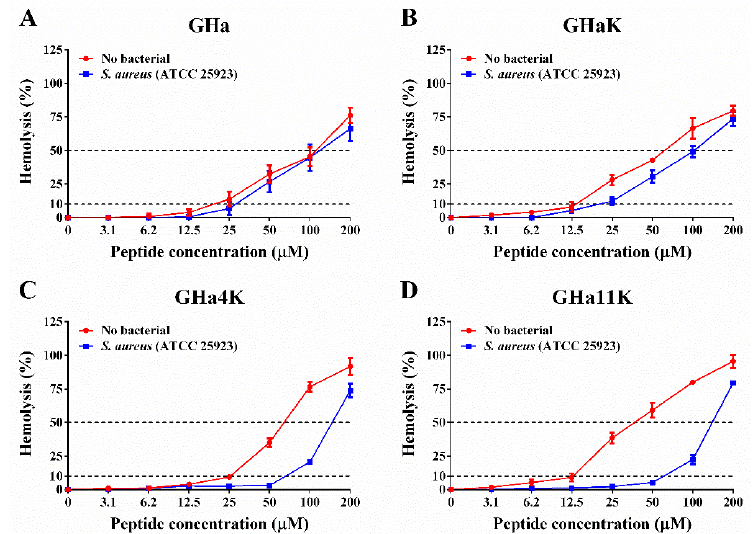
Figure 6. Hemolytic activity of ( A ) GHa, ( B ) GHaK, ( C ) GHa4K, and ( D ) GHa11K in the absence and presence of S. aureus . Dashed lines represent 10% and 50% hemolysis. Hemolysis values ≤ 10% are considered to be non-hemolytic. Data are reported as mean ± standard error of three independent experiments. The red line represents bacteria-free, and the blue line represents the hemolytic activity in the presence of S. aureus .